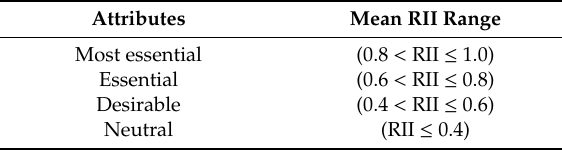
Figure 4. Mean Relative Importance Index (RII). Table 6. Evaluation rule.